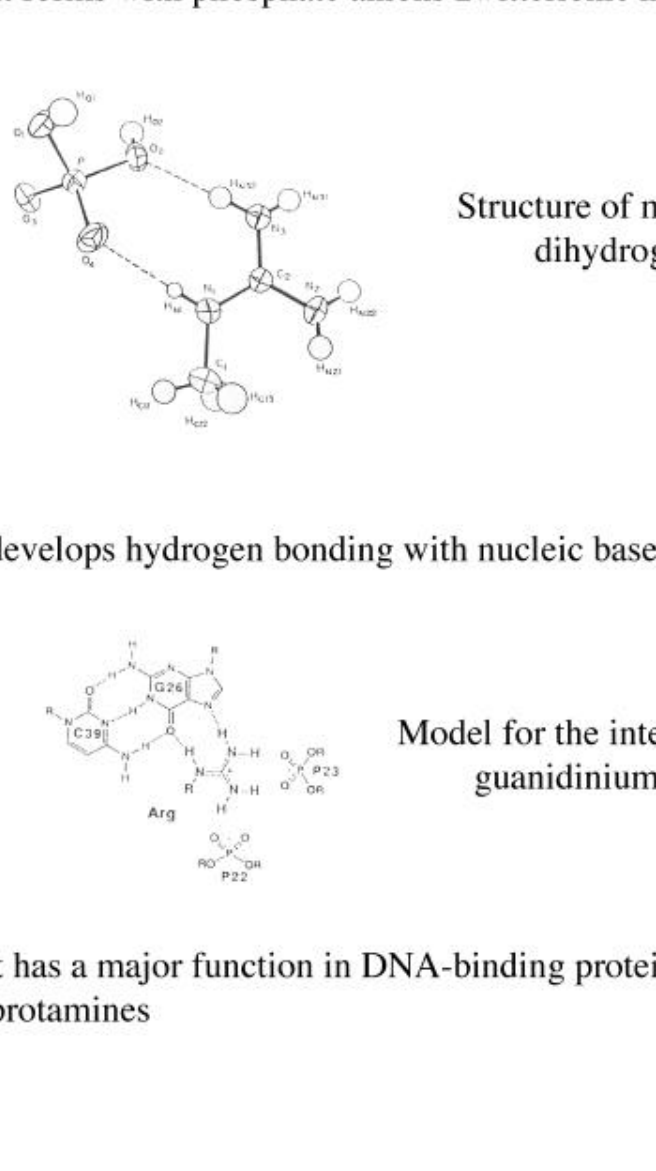
Figure 16. Caracteristics of the guanidinium